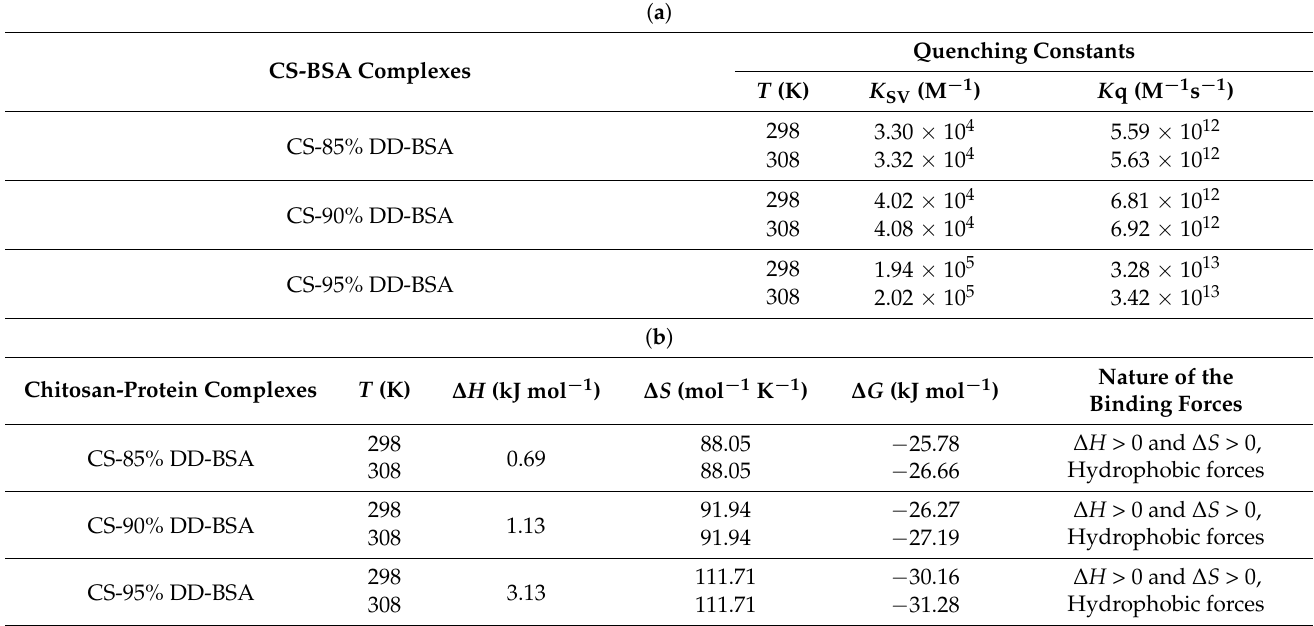
Table 3. (a) The quenching constants of BSA by CS (85% DD, 90% DD and 95% DD) at two different temperatures. (b) Thermodynamic parameters of CS (85% DD, 90% DD and 95% DD) forming adducts with BSA. ( a ) CS-BSA